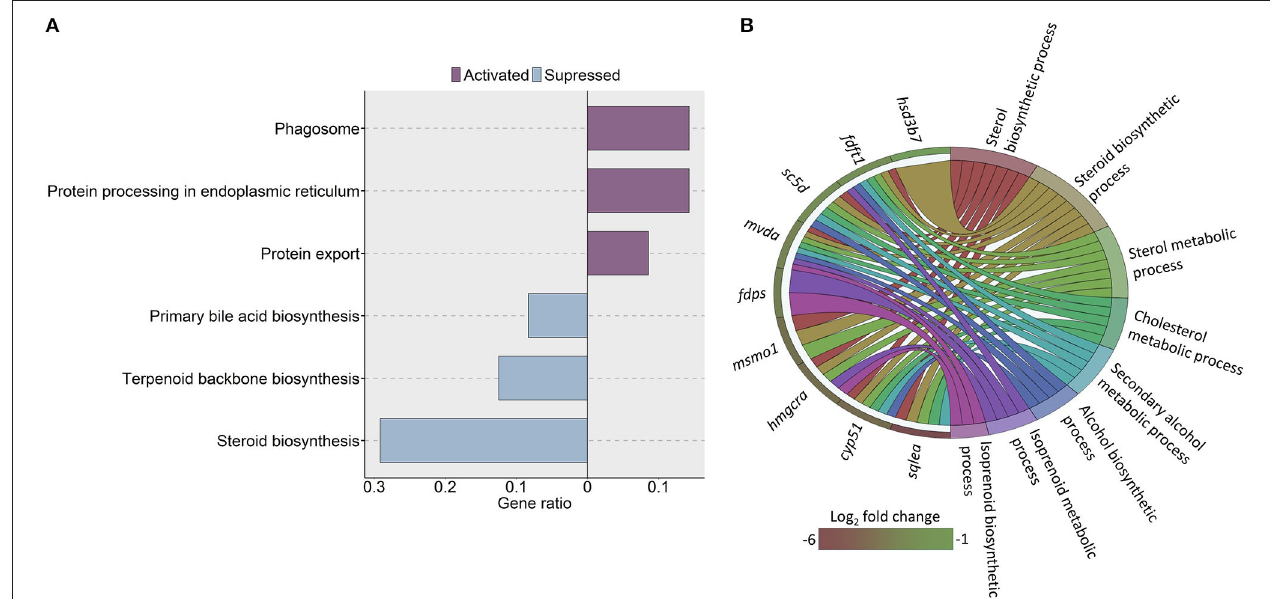
FIGURE 3 | KEGG pathways and GO terms that were enriched in zebrafish fed a high cholesterol diet. (A) Significantly altered KEGG pathways in the high cholesterol diet (HC) group, based on the altered genes in the HC group compared to the low cholesterol (CT) diet group. Each treatment group consisted of at least five biological replicates. (B) Chord diagram showing the link between the enriched GO terms and the associated genes that were detected as downregulated in the HC vs. CT group comparison. Genes that were considered for the enrichment analyses are shown on the left half of the circle. The gradient color bar intensity varies with the Log 2 fold